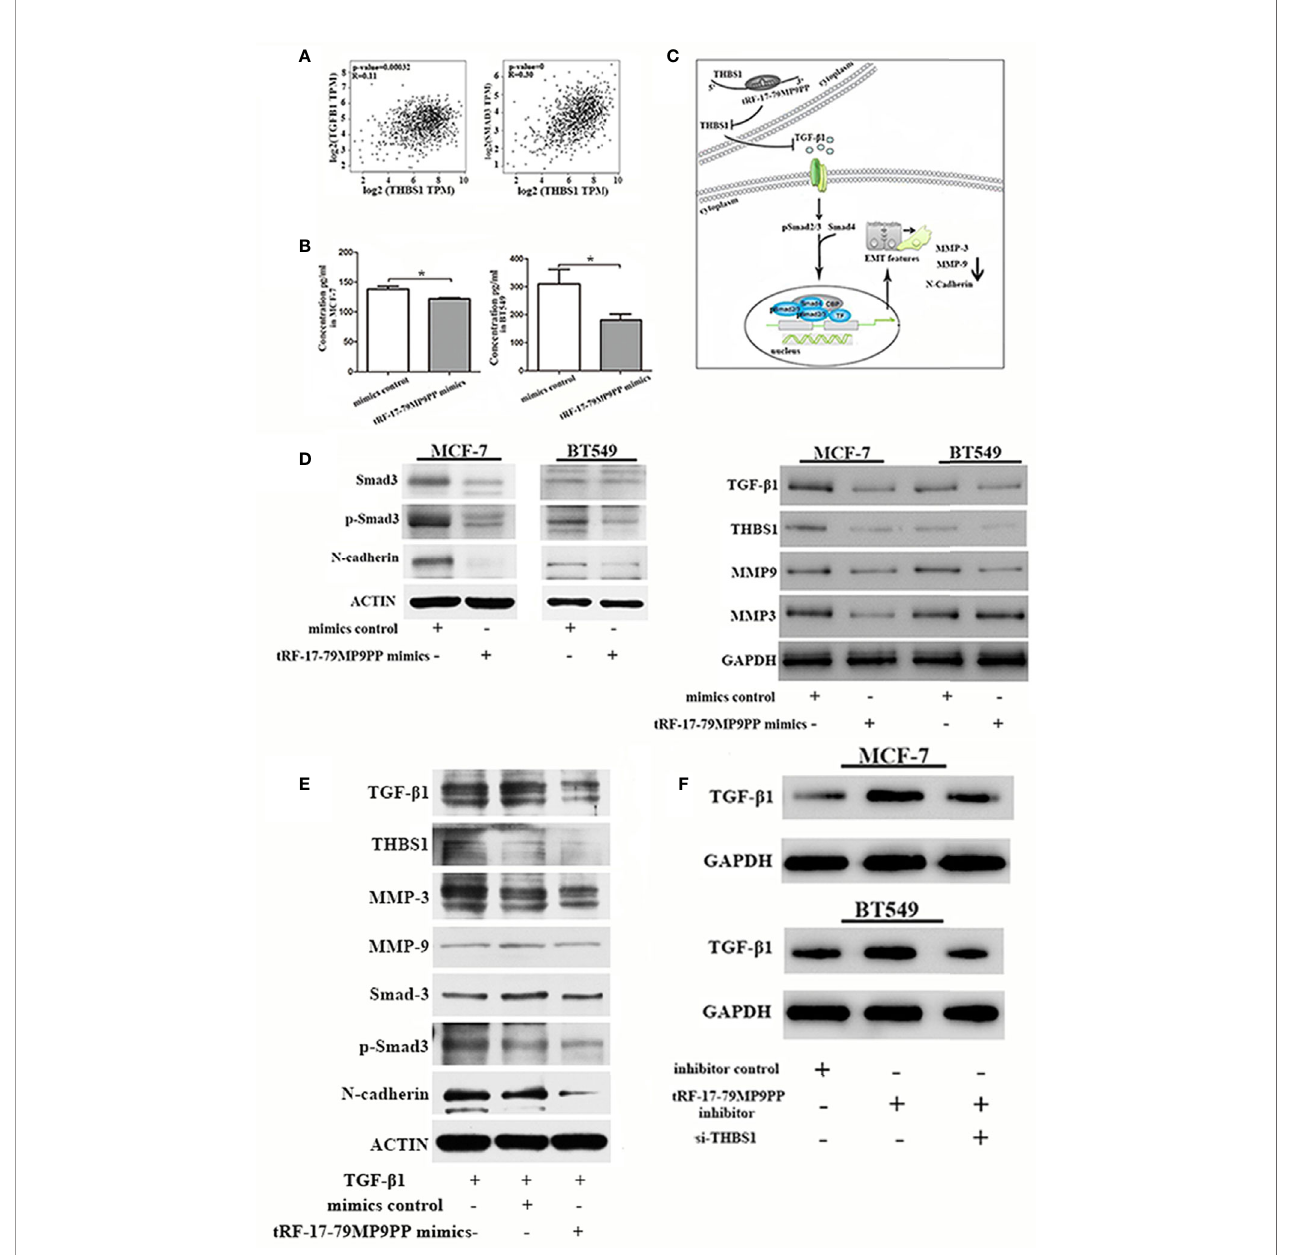
FIGURE 7 | tRF-17-79MP9PP regulates TGF- b 1 signaling pathway. (A) The expression correlation between THBS1 and TGF- b 1 and Smad3 genes in clinical breast cancer specimens. (B) The amounts of TGF- b 1 in the culture supernatants of MCF-7 and BT549 cells determined by ELISA. Data represent three independent experiments. (C) Proposed working model. tRF-17-79MP9PP-mediated THBS1 inhibition may lead to the inactivation of TGF- b 1/Smad3 signaling pathway in breast cancer cells. (D) Western-blot analysis protein levels in breast cancer cells transfected with tRF-17-79MP9PP mimics or control. (E) Western-blot analysis protein levels in transfected cells with TGF- b 1 treatment in MCF-7 cell. (F) Western-blot analysis protein levels in MCF-7 and BT549 cells co-transfected with tRF-17- 79MP9PP inhibitor and si-THBS1. b -actin or GAPDH was used as a loading control. * p < 0.05 statistically signi fi